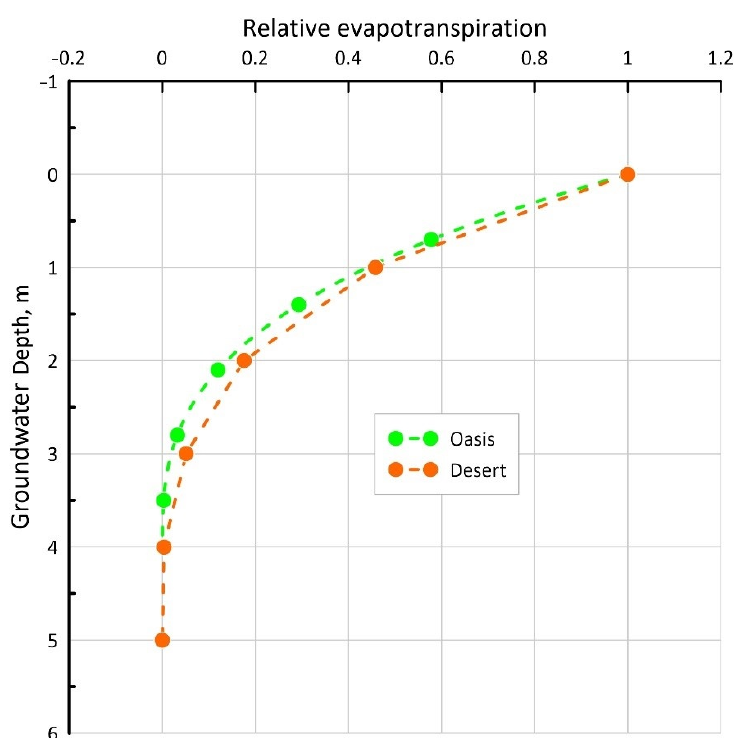
Figure 9. Dependence of relative evapotranspiration on the depth of the groundwater table according to Wang et al. [25] and Liu [38] for oasis and desert areas, respectively.